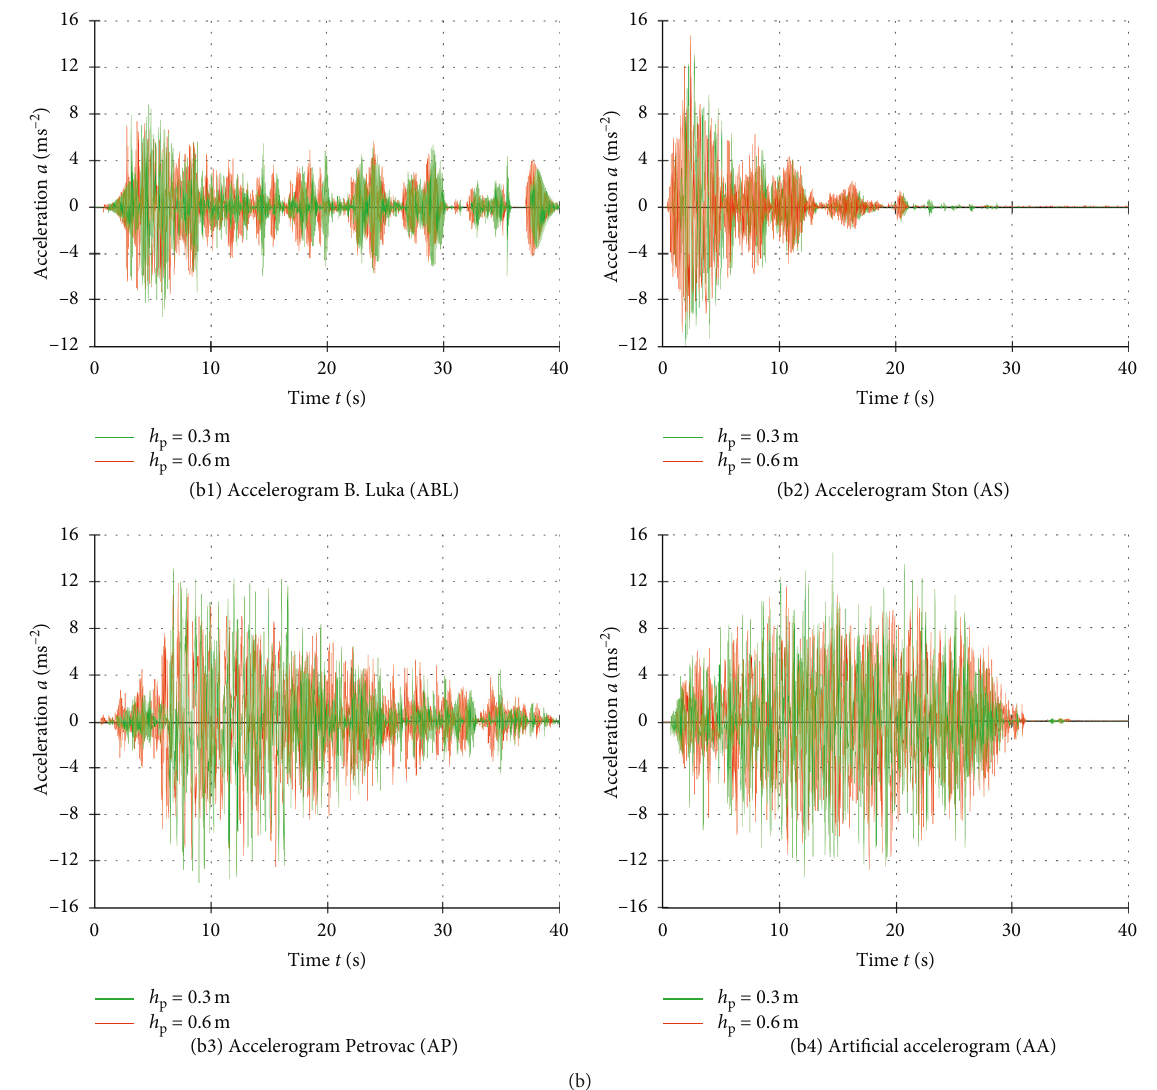
Figure 12: The effect of aseismic layer thicknesses on horizontal acceleration a . (a) PGA � 0.2g. (b) PGA � 0.6 g.